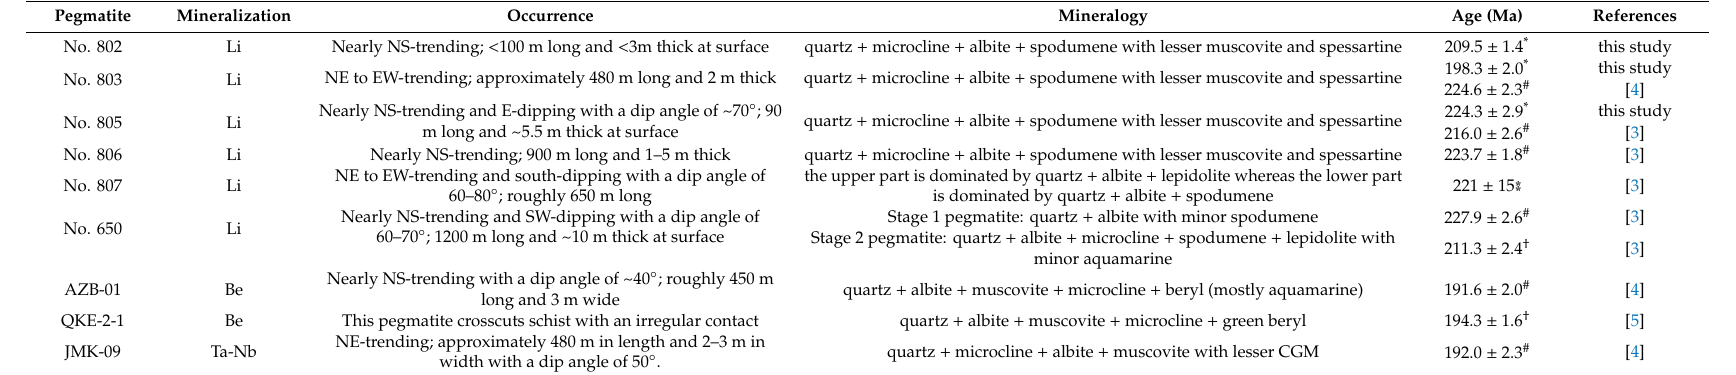
Table 1. Geology and ages of representative pegmatite dikes in the Kalu'an-Azubai